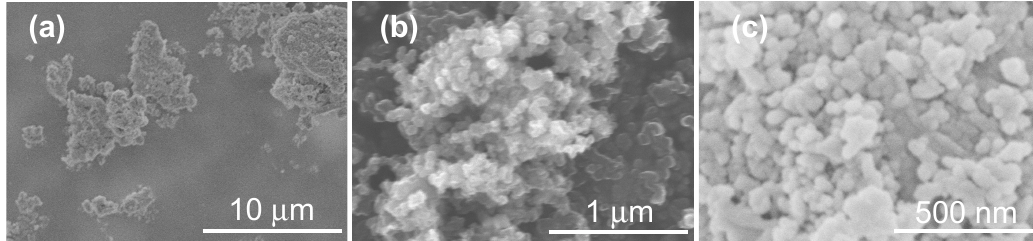
Figure 1. FESEM photographs of ( a ) silicomanganese slag (SS); ( b ) carbon black (CB); ( c ) 4.5EASSC.